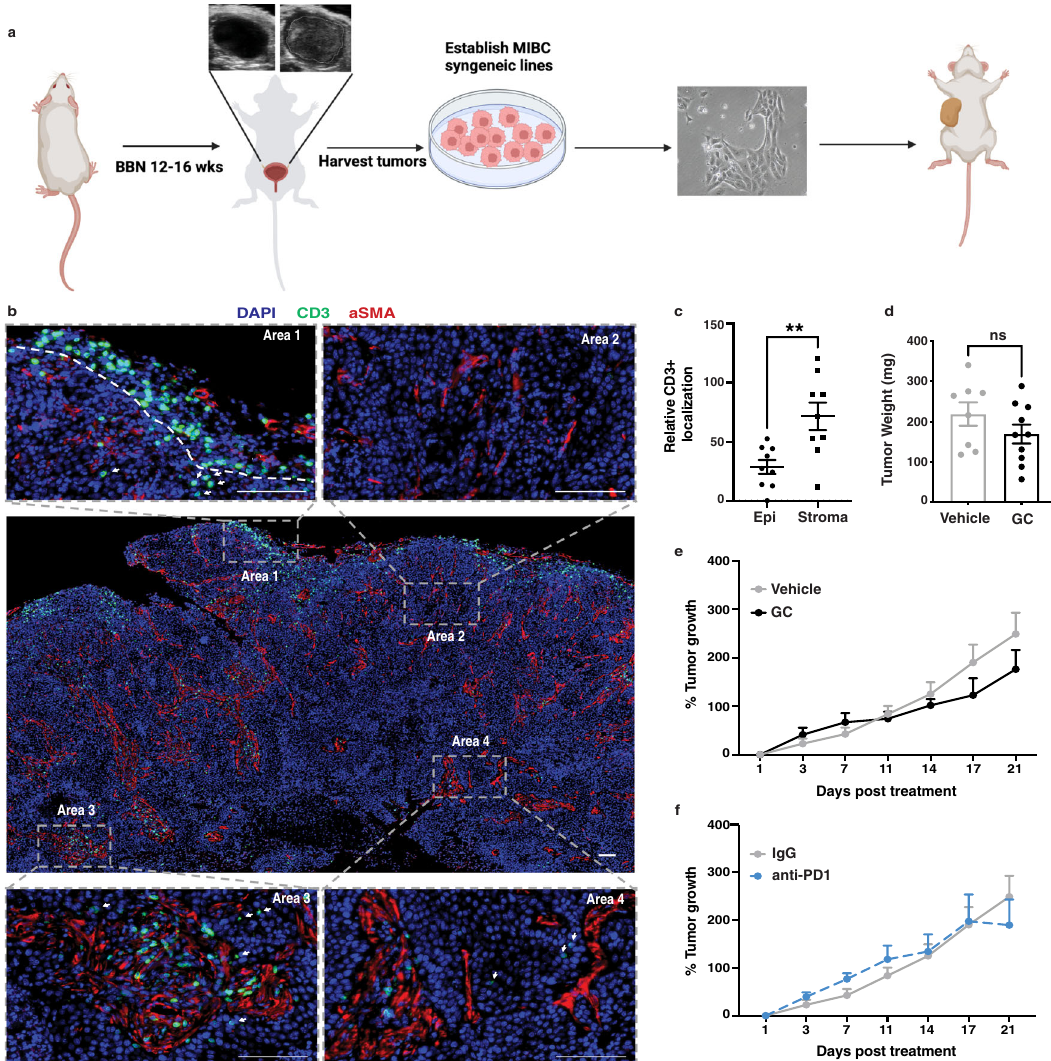
Fig. 1 Development of a chemo- and immune-checkpoint-resistant MIBC model, with a T-cell-non-in fl amed phenotype. a Schematic for establishment of muscle-invasive bladder cancer syngeneic lines. b Immuno fl uorescence analysis of CD3 + T-cell in fi ltration and aSMA expression in G69 treatment-naïve tumor tissues (Scale bar: 100 μ m; Images representative of n = 3 independent experiments). c Relative localization of CD3 + T cells in treatment naïve G69 tumors. CD3 + T cells in regions of interest were quanti fi ed and normalized to average CD3 + T-cell in fi ltration ( n = 9 biologically independent samples). Data are presented as mean values± SEM. (** — Two-tailed, unpaired t -test p = 0.0045) d, e Weight and growth curve of G69 tumors treated with vehicle ( n = 8 biologically independent animals) or gemcitabine (120 mg/kg) and cisplatin (6 mg/kg) ( n = 10 biologically independent animals) for two cycles. Data are presented as mean values ± SEM. (Two-tailed, unpaired t -test at endpoint values). f Growth curve of vehicle ( n = 8 biologically independent animals) or anti-PD1-treated ( n = 3 biologically independent animals) (200 mg/mouse) G69 tumors monitored for 21 days. Data are presented as mean values ± SEM. (Two-tailed, unpaired t -test at endpoint values). Source data are provided as a Source data fi le. ns: not signi fi